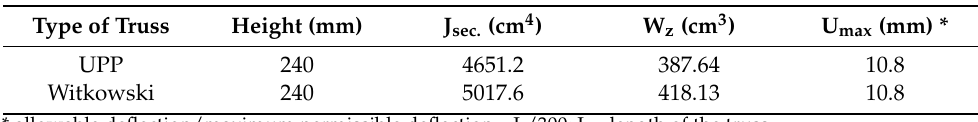
Table 4. Results for